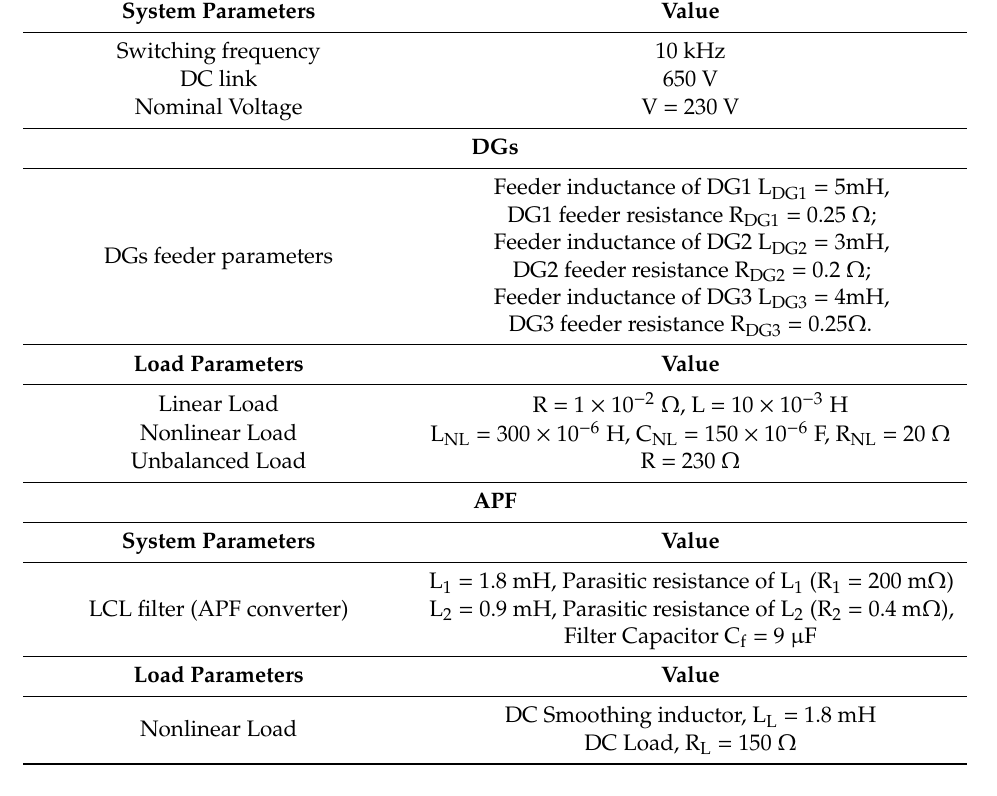
Table 2. Control